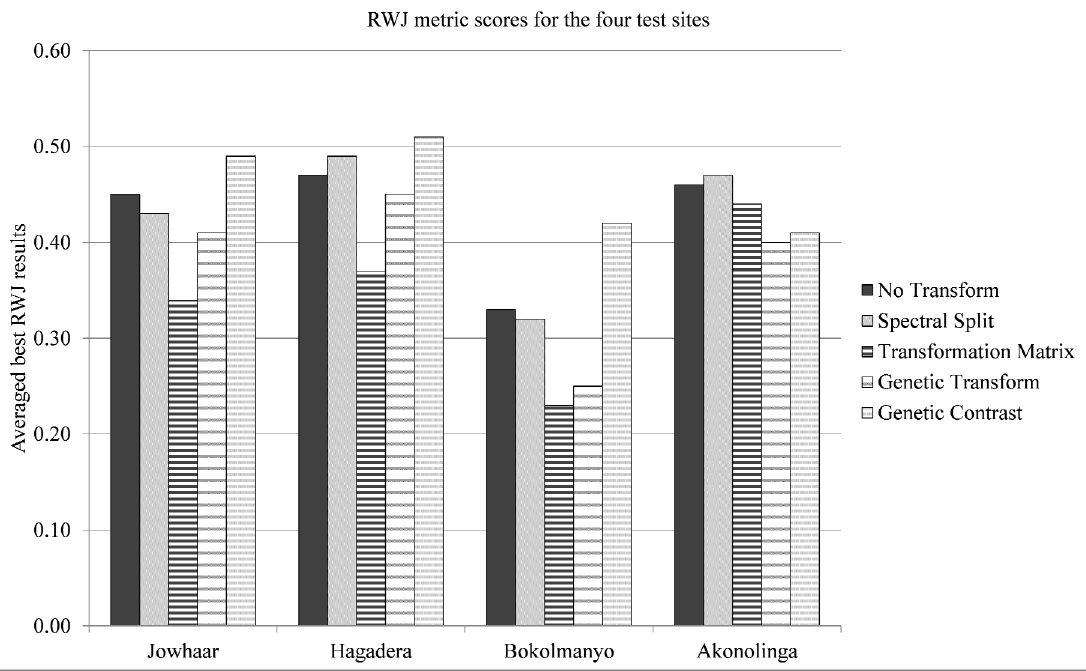
Figure 11. Example of best segmentation results achieved on ( a ) original image and ( b ) an image transformed with the Genetic Transform function for the Bokolmanyo site using the MS segmentation algorithm and RWJ